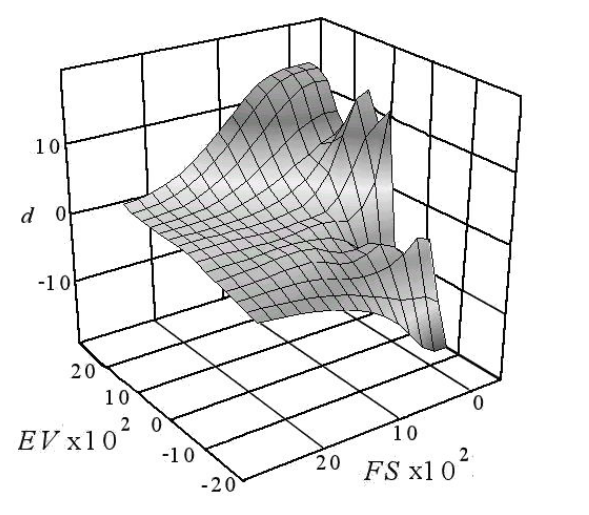
Figure 30. d divergence coefficient and chaos at equilibrium